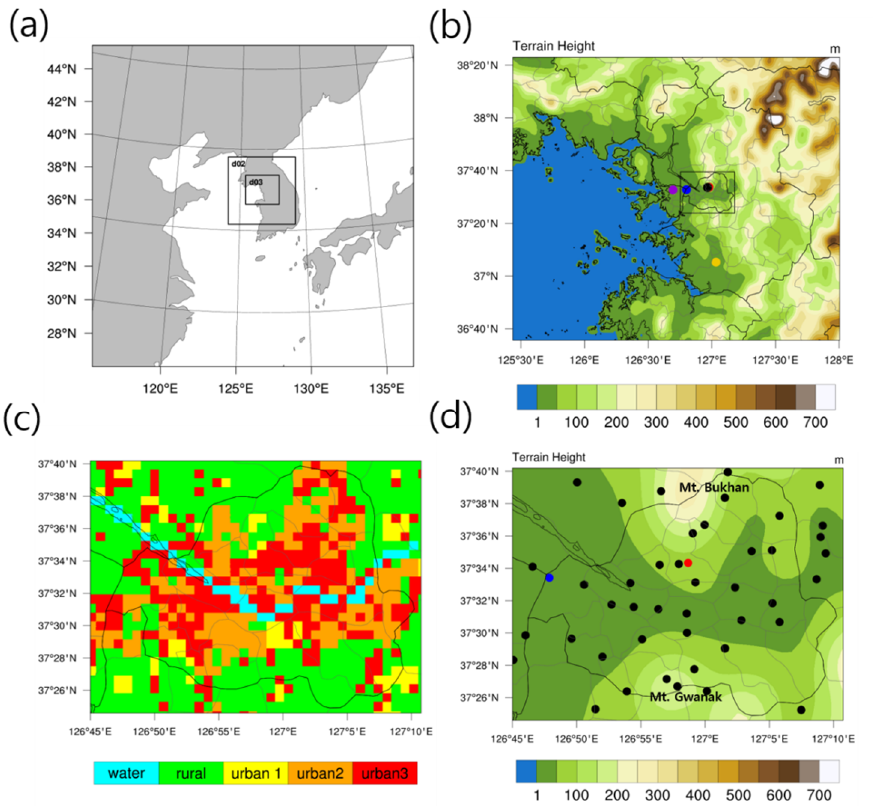
Figure 1. ( a ) Domain configuration of the WRF model simulation, ( b ) the horizontal distribution of terrain height in domain 3. The black box in domain 3 denotes the analysis domain of the Seoul Metropolitan Area, and the horizontal distribution of ( c ) land use and ( d ) terrain height in the analysis domain in this study. In ( b ), the location of observation stations is marked by dots (purple: Gongchondong, blue: Gimpo airport, black: Seoul, red: Gwanghwamun, yellow: Osan). In ( d ), black dots indicate all of the AWS and ASOS stations in the analysis domain.